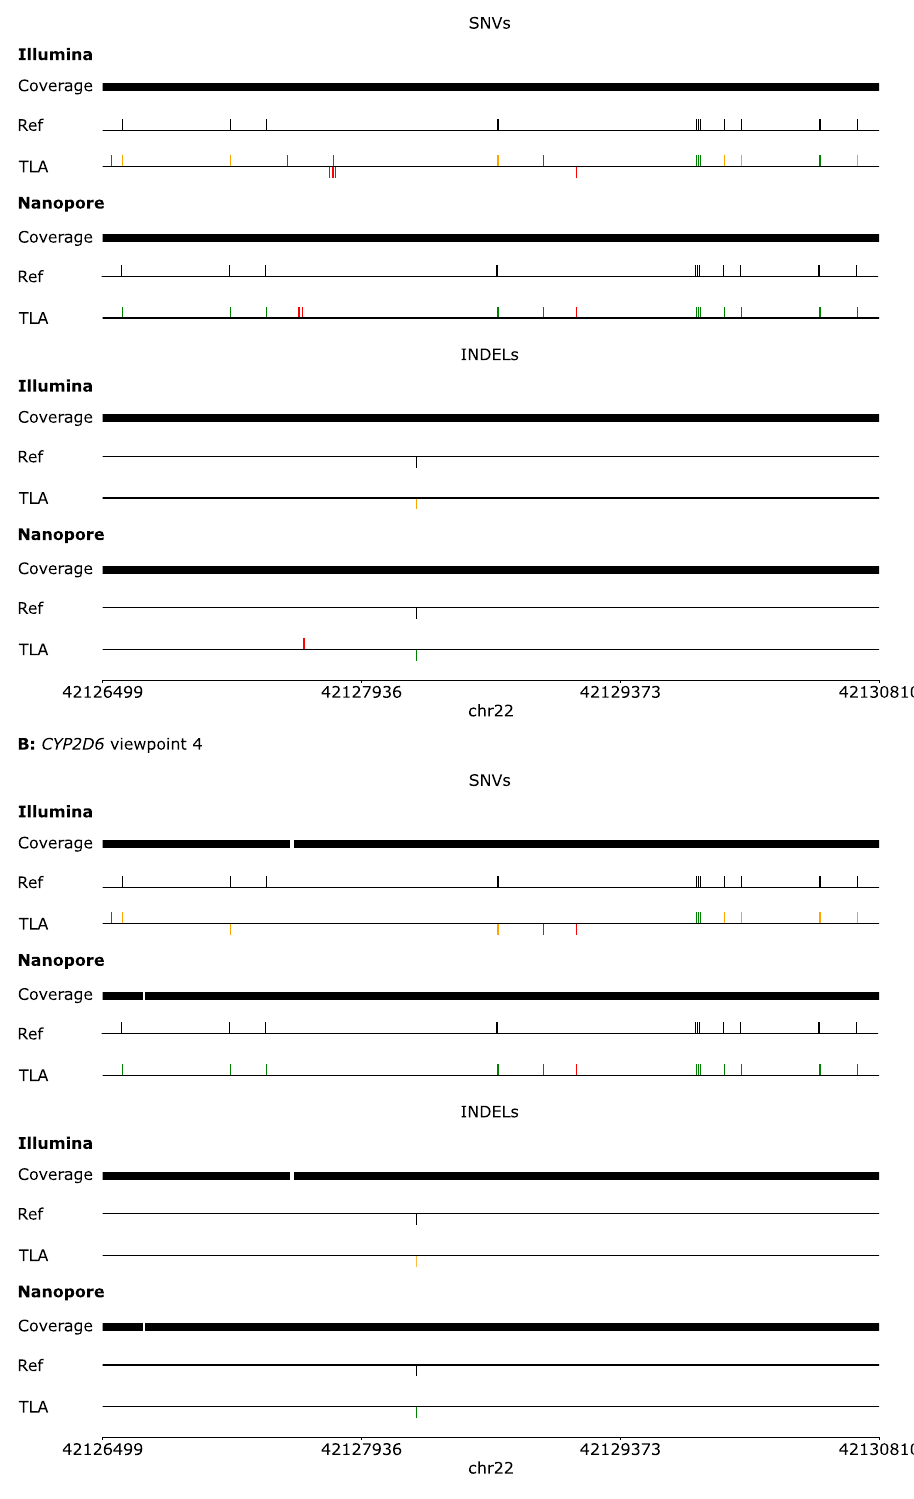
Figure 3. Coverage, variant calling, and phasing results for CYP2D6 . ( A ): Results for all viewpoints of CYP2D6 ; ( B ): Results for viewpoint 4 of CYP2D6 . Coverage: bars indicate where sufficient depth is reached: 25X for Illumina and 100X for Nanopore. Ref: The reference line shows the variants present in the reference set of Krusche et al . 23 . Bars plotted at the same side of the reference line (top or bottom) represent variants from the same allele. TLA: red bars represent discordant variants, orange bars represent variants that were phased incorrectly or that could not be phased, and green bars represent concordantly called and phased